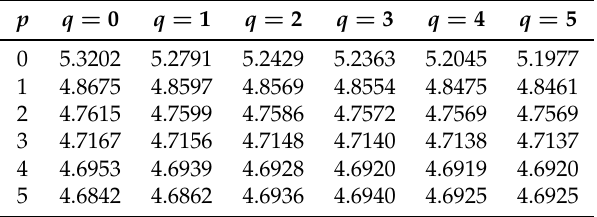
Table A10. Bit rates (bits/pixels), obtained for various values of p and q , on “AAMU Scene-2”. p q = 0 q = 1 q = 2 q = 3 q = 4 q =